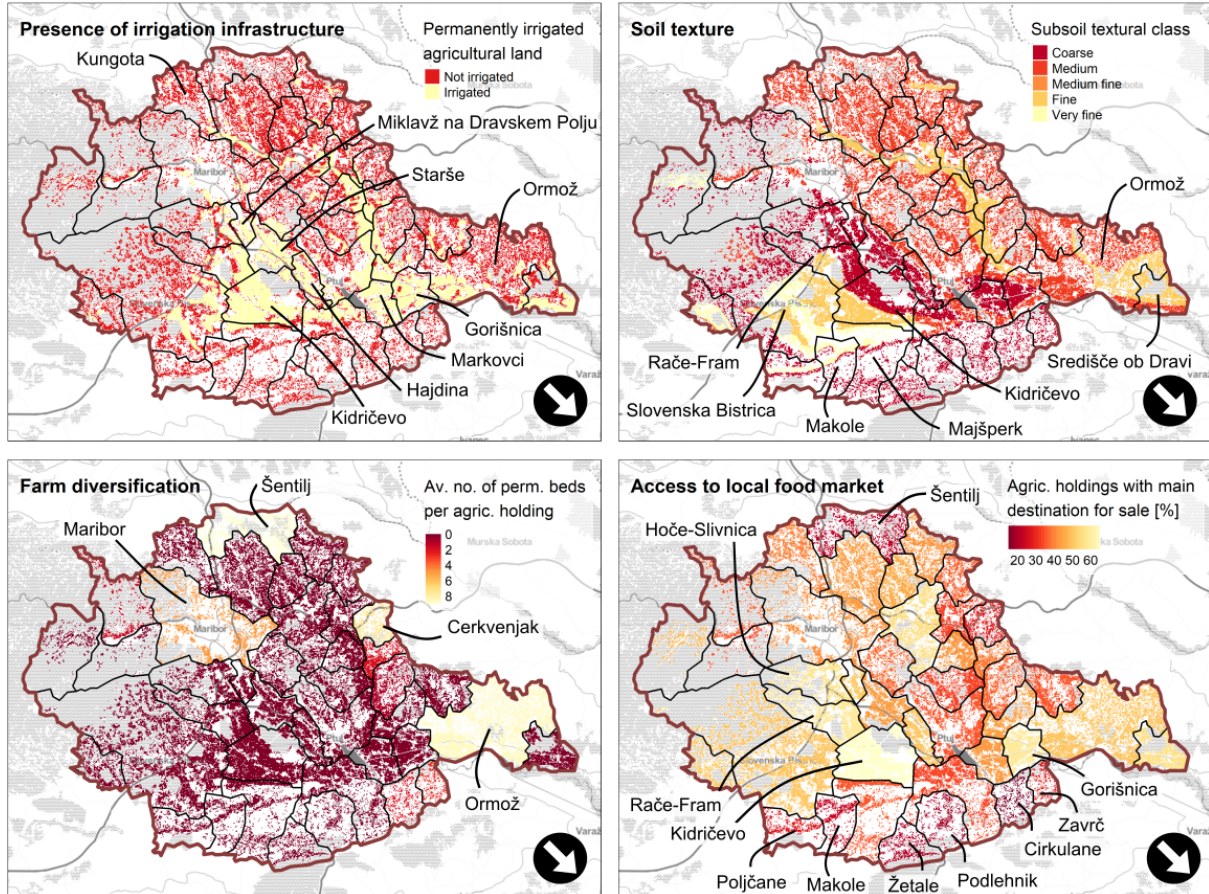
Figure 6. Podravska’s most important factors (bold title) masked with agricultural used land and describing the regions’ vulnerability accord- ing to the experts (Fig. 3), supported by data of the indicators (see legend). The factor’s increasing or decreasing effect on the vulnerability is indicated by the arrow in the map (bottom right) and by the colour choice (the darker the colour, the higher the vulnerability). LAU2 regions are indicated by black borders and labelled when showing relatively high or low